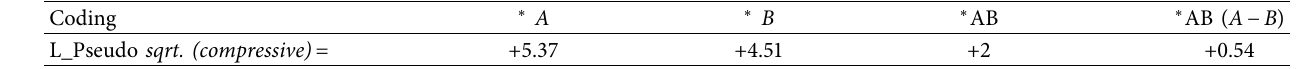
Table 20: Final equation in terms of L_pseudo components.